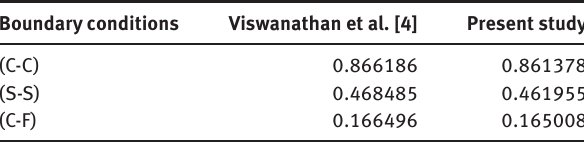
Table 2 Convergence study of the present finite element solutions with the literature results for cross-ply (0 ° /90 ° ) annular plates.